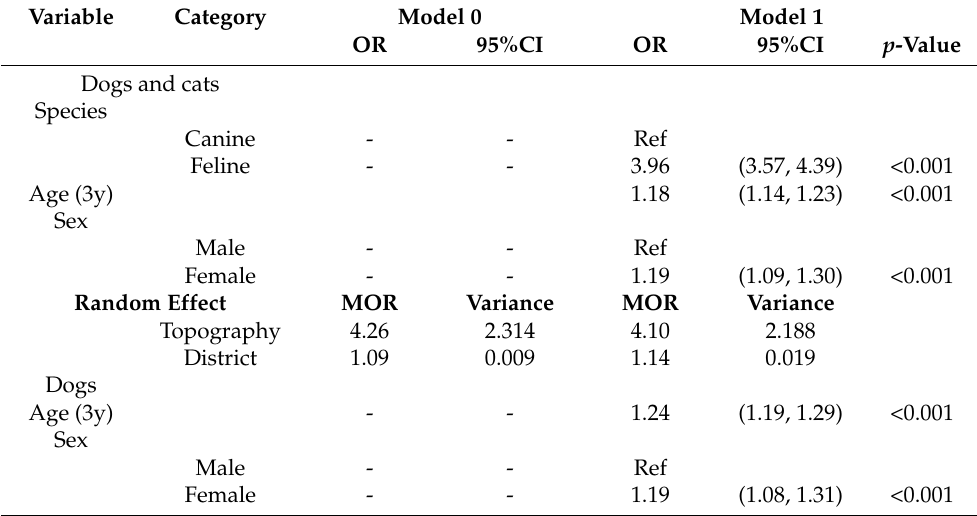
Table 3. Multivariable logistic regression models. Without adjusting for species, age, and sex (Model 0) and with adjustments (Model 1) for risk factors for malignant tumors in the Vet-OncoNet database. Topography of tumors (topography group), breed, and geographical location (district) were considered as random